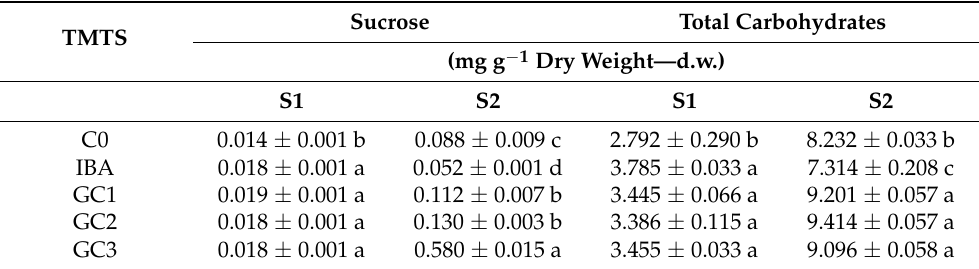
Table 7. Biochemical parameters: sucrose and total carbohydrates (mg g − 1 d.w.) in Lantana camara (S1) and Abelia × grandiflora (S2), influenced by rooting promoters at different concentrations (C). Sucrose Total Carbohydrates TMTS (mg g − 1 Dry Weight—d.w.) S1 S2 S1